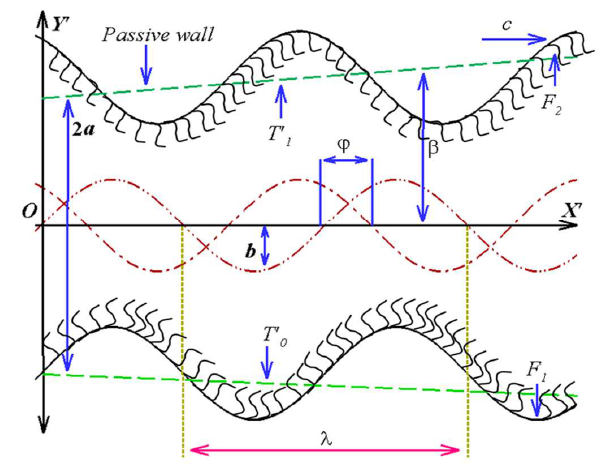
Figure 1 . Geometrical structure of the non-uniform flow. Figure 1. Geometrical structure of the non-uniform